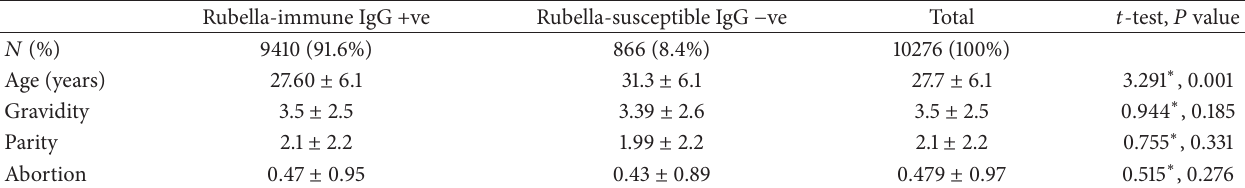
Table 2: Results comparing the immune and nonimmune pregnant women. Rubella-immune IgG +ve